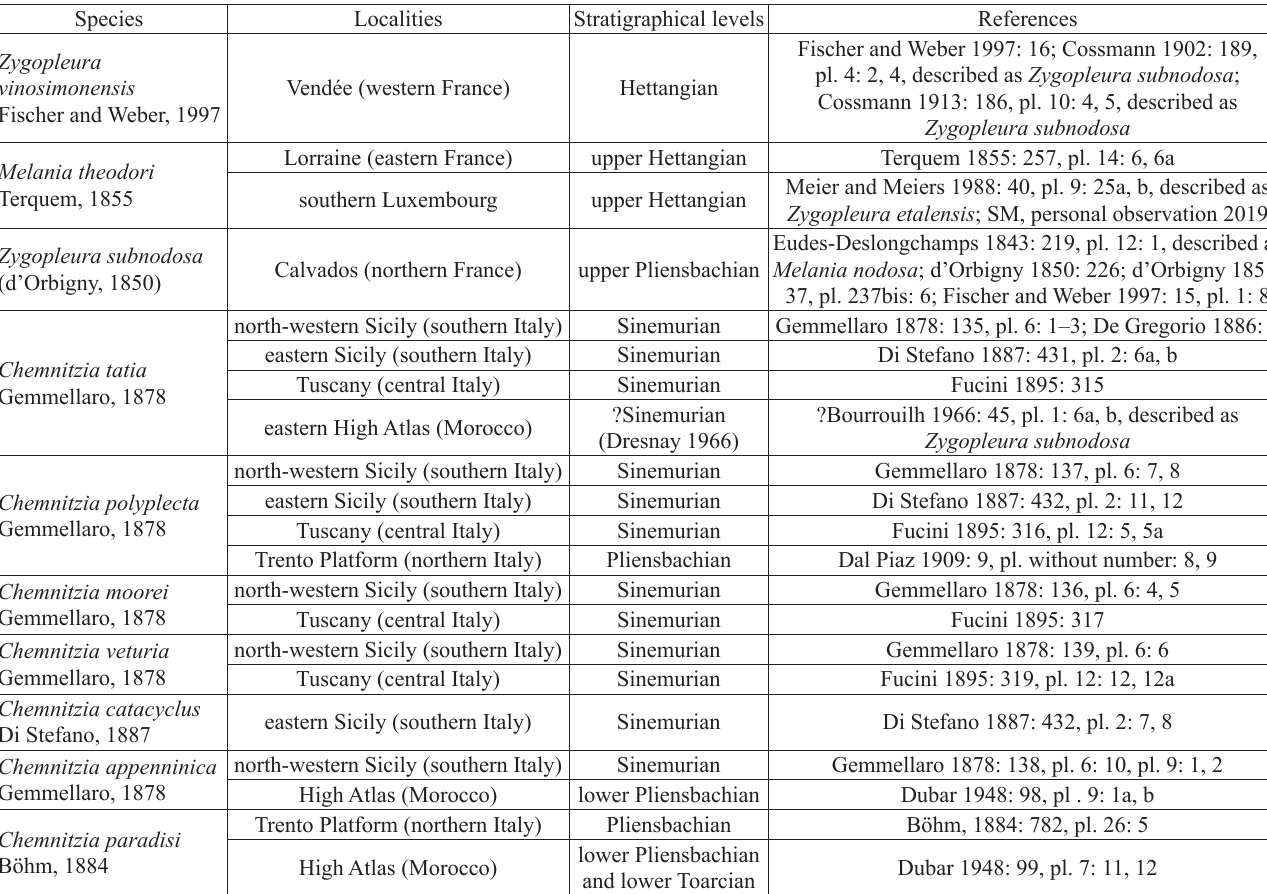
Table 1. List, references, localities, and stratigraphical position of the Early Jurassic Zygopleura ­like species possibly related to Ederazyga .